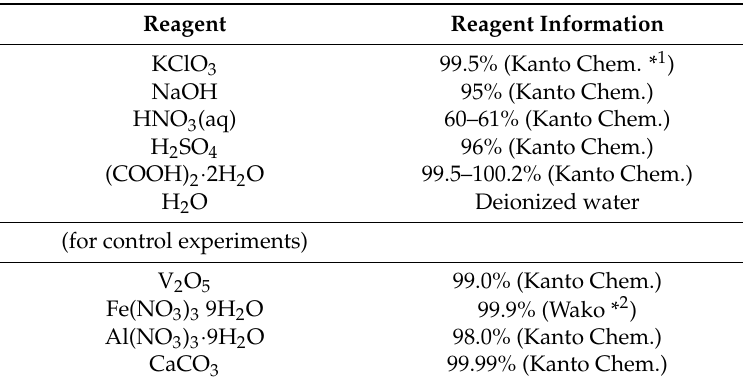
Table 2. Chemical reagents used in this